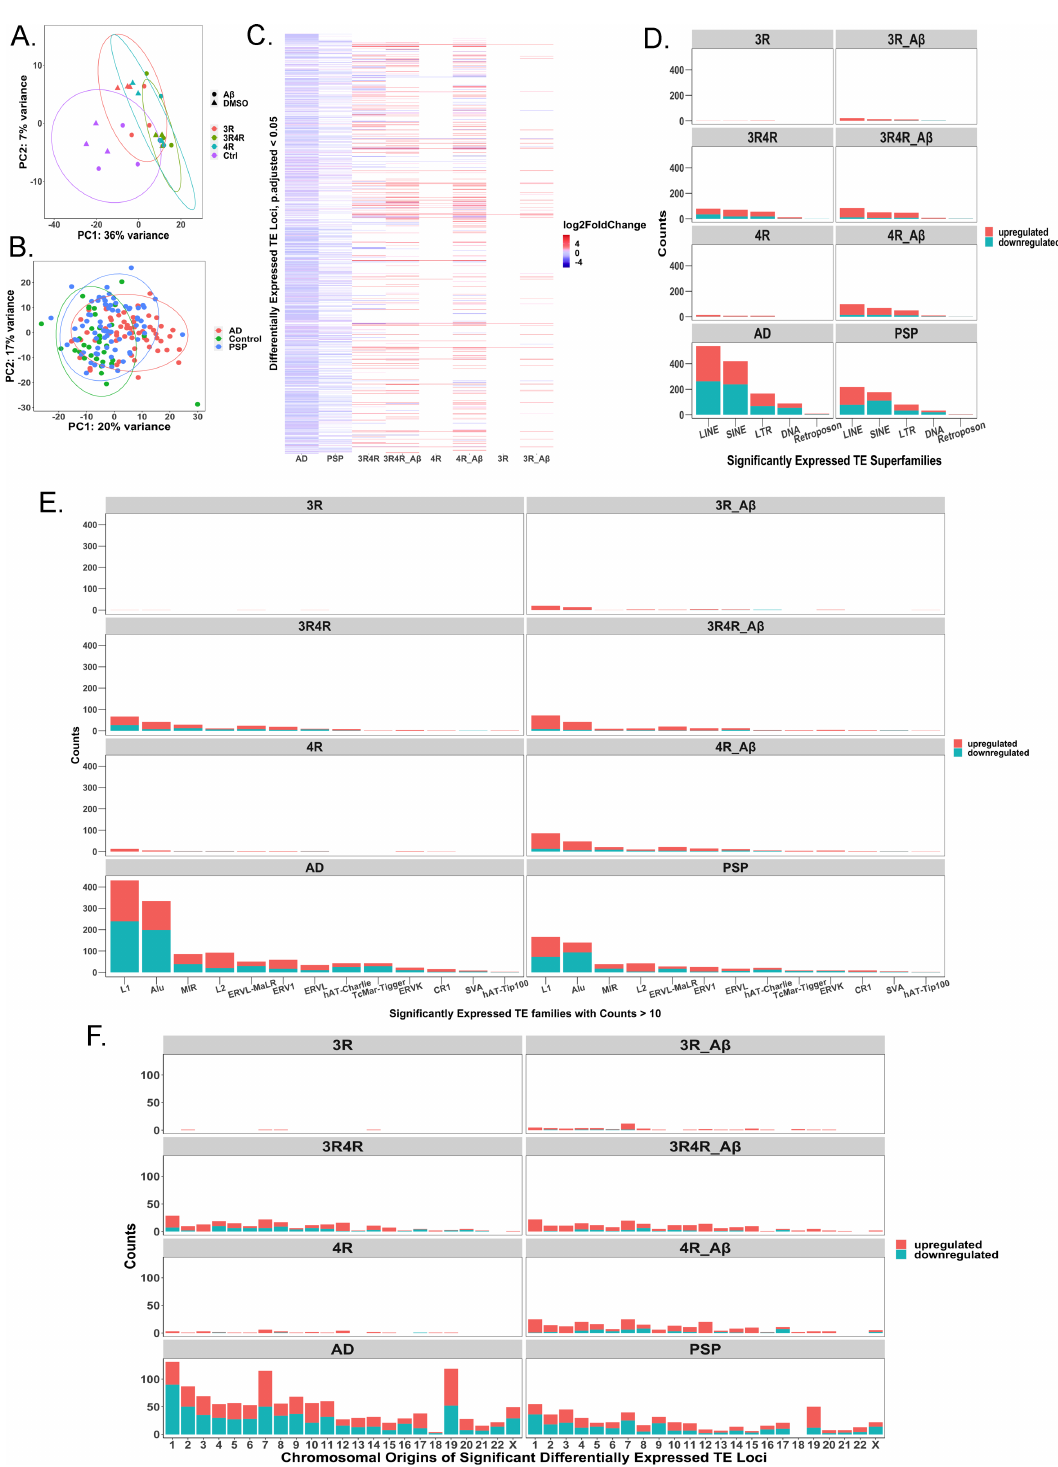
Fig 6. Classification of significantly differentially expressed locus-specific transposable elements by transposable element superfamily and family. (A) PCA displaying grouping by locus-specific TE expression between lentivirus and treatment conditions; PC1 accounts for 36% of variation between conditions (N = 3). (B) PCA displaying grouping by locus-specific TE expression between AD (N = 60), control (N = 33), and PSP (N = 71) patients. PC1 accounts for 20% of variation, while PC2 accounts for 17% of variation. (C) Heatmap showing log-fold change in expression of TE loci considered significantly differentially expressed (FDR